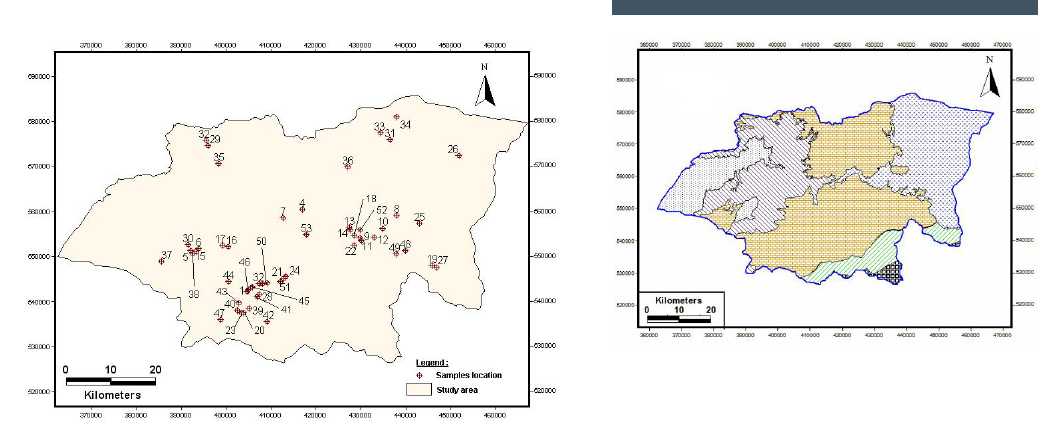
Figure 3. Hydrogeological map of the study area (modified after